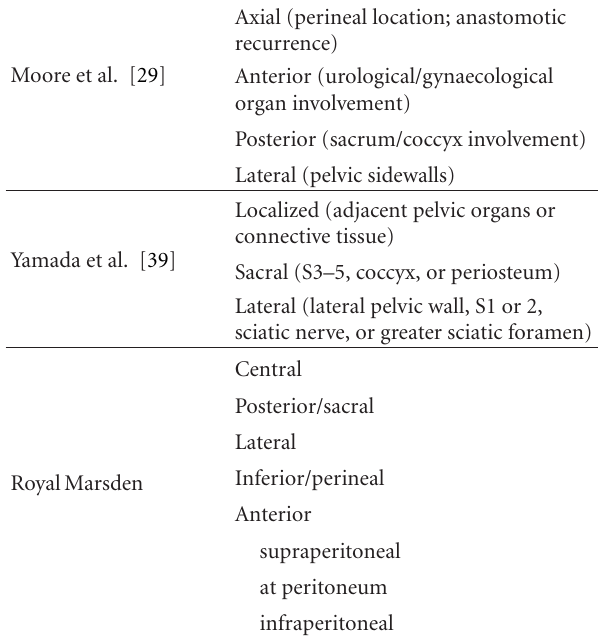
Table 1: Classification of anatomical location of pelvic